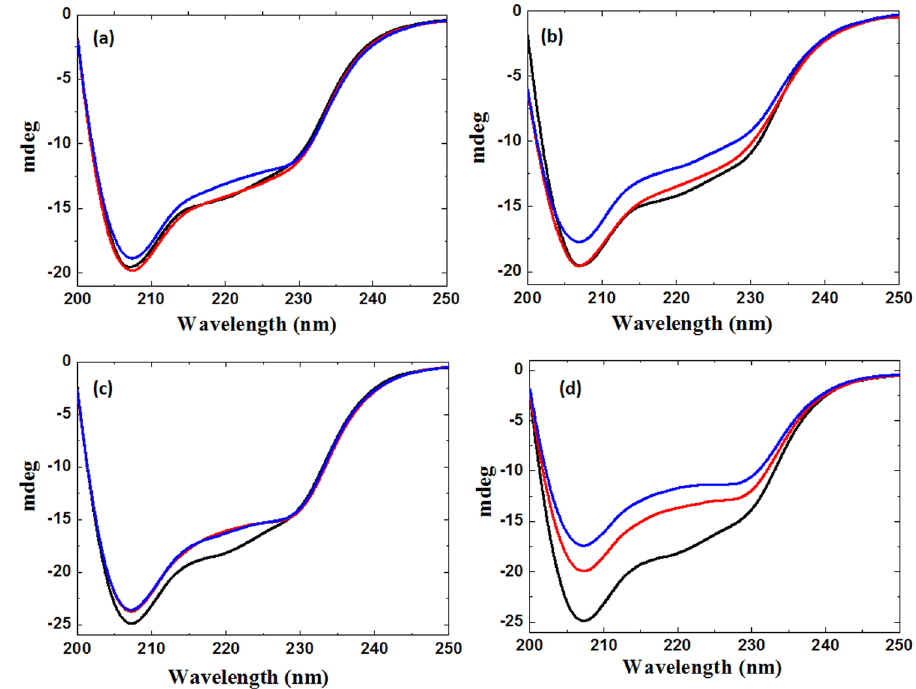
Figure 2. CD spectrum after plasma treatment. The far-UV CD spectrum of lysozyme were acquired for ( a ) Air-DBD; ( b ) N 2 -DBD; ( c ) Air-APPJ and ( d ) N 2 -APPJ treatment for 8 min (red) and 12 min